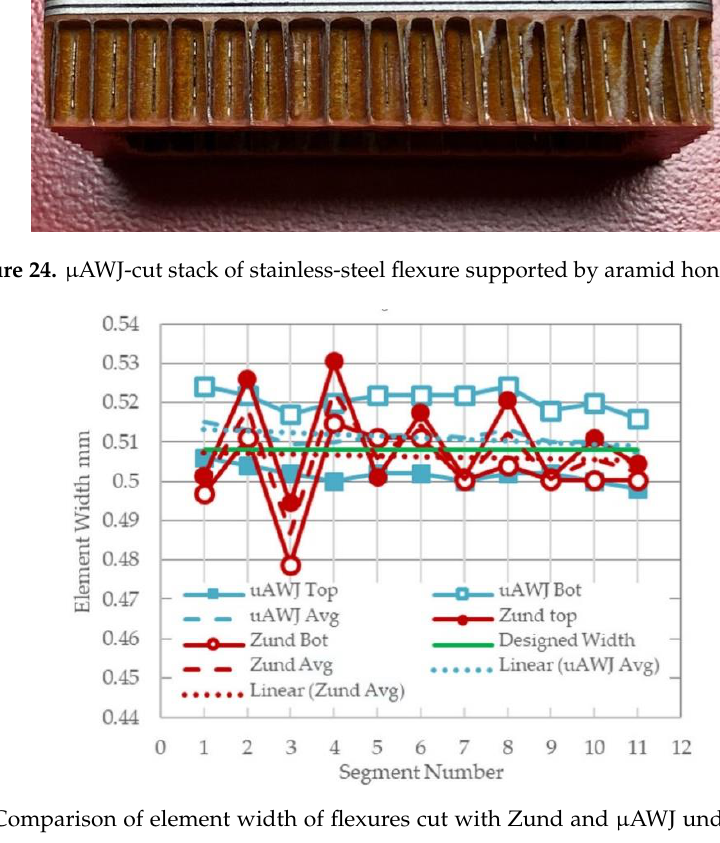
Figure 25. Comparison of element width of flexures cut with Zund and µ AWJ under stack cutting at mid-span.